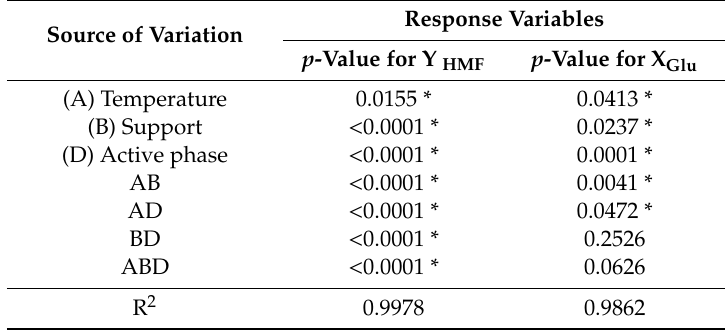
Table 2. Analysis of variance of the main e ff ects and their interactions on 5-hydroxymethylfurfural (HMF) yield (Y HMF ) and glucose conversion (X Glu ) based on Taguchi’s L 8 orthogonal